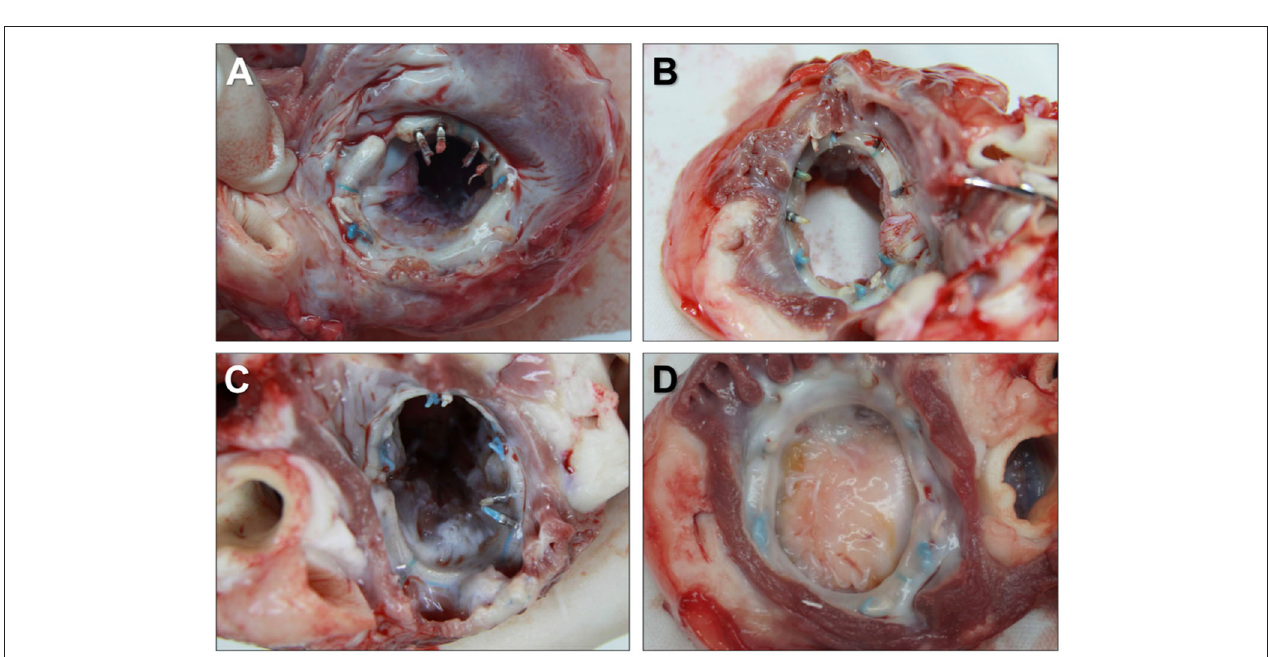
FIGURE 4 | Representative in situ view of the left atrium at the implantation site of the annuloplasty ring. Annuloplasty rings were tightly secured by 6 Easy-Knot clips and 6 hand-made knots without any disengagement or displacement at indicated time points. Day 30 (A) , Day 60 (B) , Day 90 (C) , and Day 180 (D) .